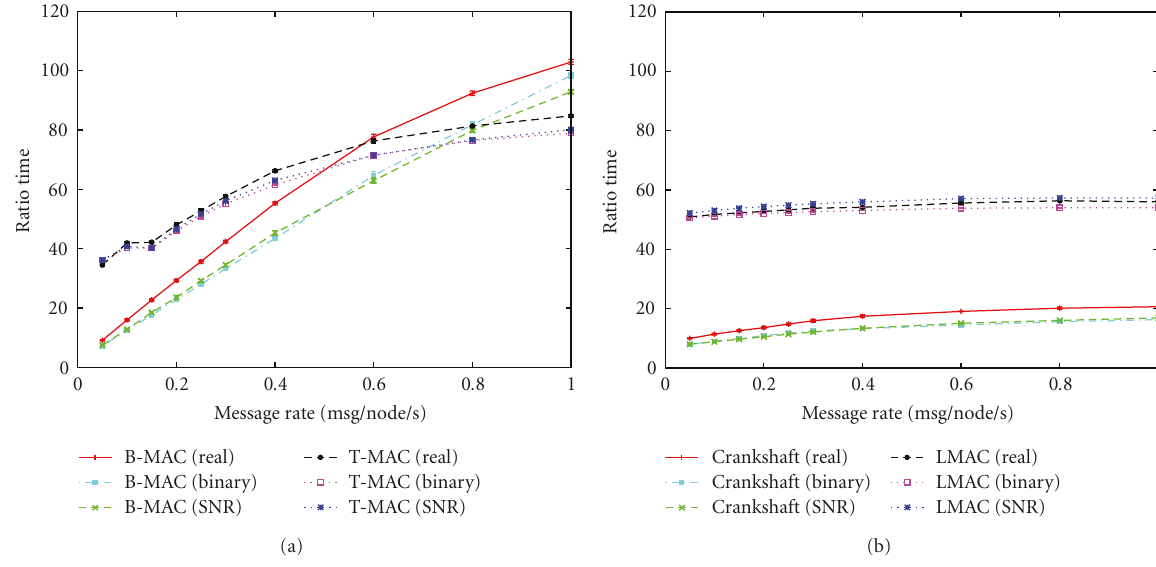
Figure 4: Radio receive times for simulated and real convergecast experiments.